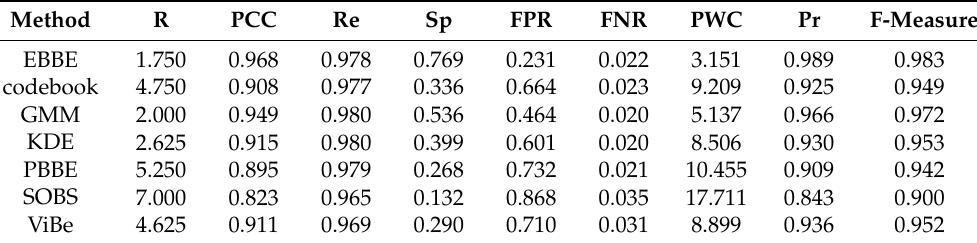
Table 4. Overall results across all test sequences.